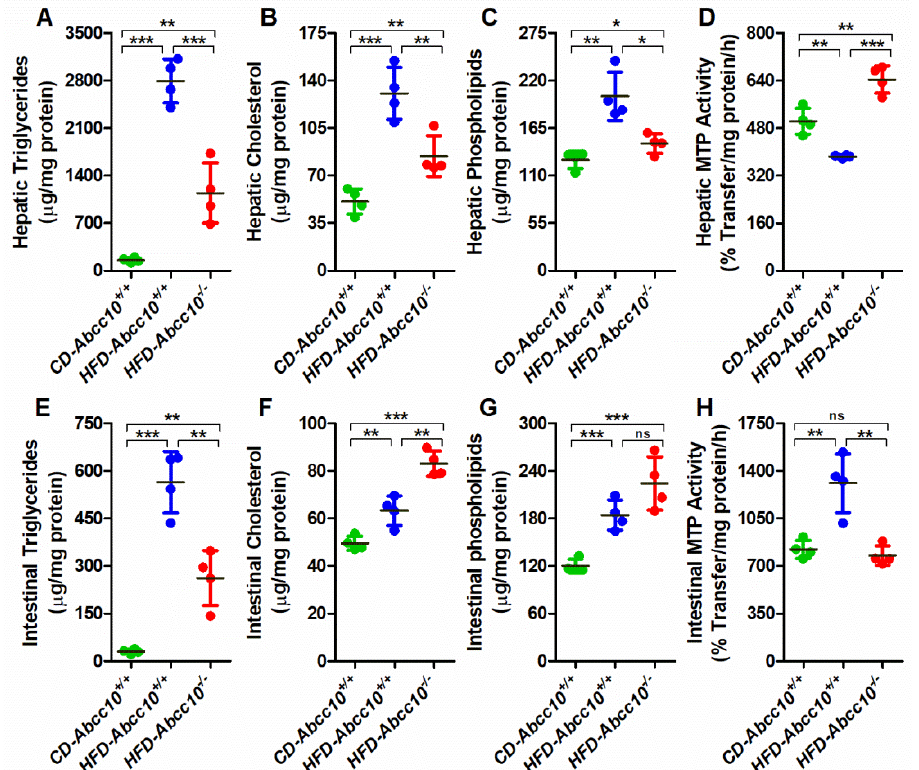
Figure 5. Deletion of Abcc10 gene decreases plasma and tissue triglycerides in high-fat-diet-fed mice. Eight-week-old Abcc10 +/+ ( HFD-Abcc10 +/+ , n = 4) and Abcc10 − / − ( HFD-Abcc10 − / − , n = 5) male mice were fed high-fat obesity diet for 16 weeks. As a control, age-matched Abcc10 +/+ (CD-Abcc10 +/+ , n = 4) male mice were kept on chow diet during this period. At the end of the experiment, mice were fasted overnight and sacrificed. Liver ( A – D ) and intestine ( E – H ) were collected and used to measure triglycerides ( A , E ), cholesterol ( B , F ), phospholipids ( C , G ), and MTP activity ( D , H ). Values are plotted as replicates (mean ± SD). * p < 0.05, ** p < 0.01, and *** p < 0.001. Next, we determined the levels of lipids in the intestinal tissues. Similar to hepatic lipids, there was a significant increase in the levels of intestinal triglycerides (Figure 5E), cholesterol (Figure 5F), and phospholipids (Figure 5G) in HFD-Abcc10 +/+ mice compared to CD-Abcc10 +/+ mice. Consistent with hepatic triglycerides, deficiency of ABCC10 prevented the accumulation of intestinal triglycerides by 54% in HFD-Abcc10 − / − mice compared to HFD-Abcc10 +/+ mice (Figure 5E). Contrary to triglycerides, we observed a further increase of 31% in cholesterol (Figure 5F) and 22% in phospholipids (Figure 5G) in HFD-Abcc10 − / − mice compared to HFD-Abcc10 +/+ mice. Determination of MTP activity showed a significant increase in the intestines of HFD-Abcc10 +/+ mice compared to CD-Abcc10 +/+ mice, which was reduced in HFD-Abcc10 − / − mice (Figure 5H). These combined data suggest that deletion of ABCC10 decreases intestinal MTP activity, leading to the accumulation of cholesterol and phospholipids. Furthermore, decreased accumulation of triglycerides in the intestine may be due to decreased uptake by the